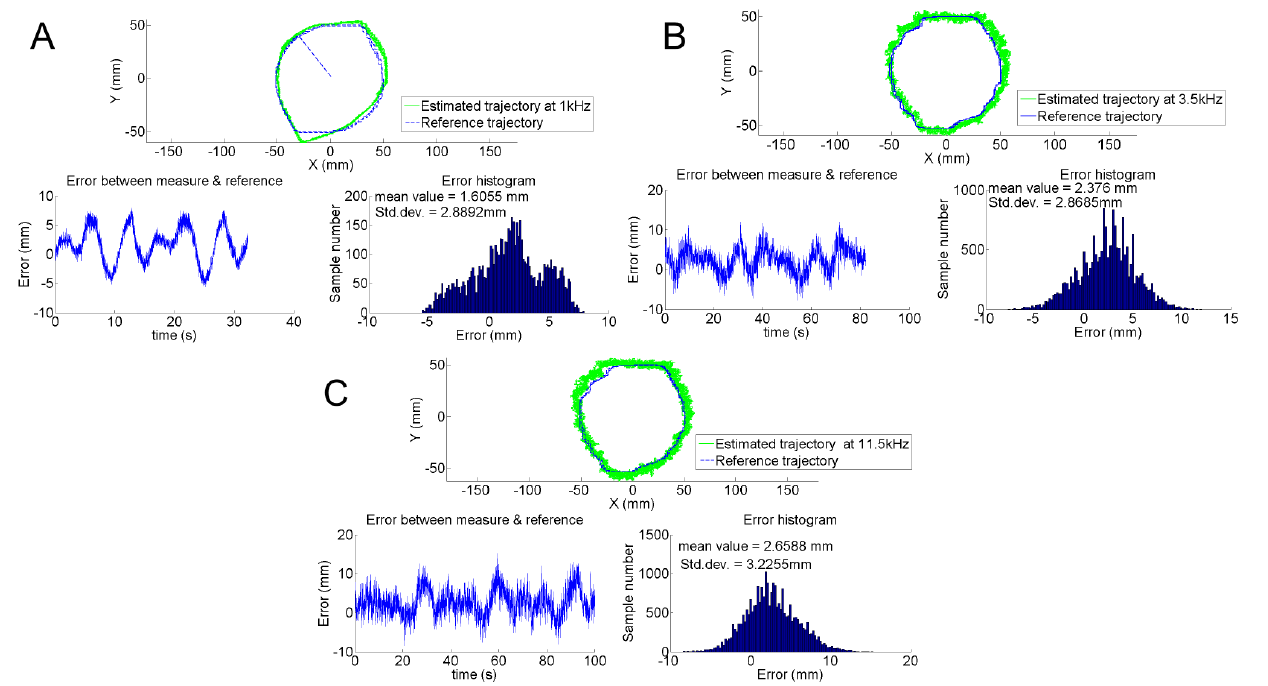
Figure 13. ( A ) Position estimation for a circular trajectory with a radius of 50 mm in the XY plane. Note that the absolute value of the position error is lower than 1 cm and that the standard deviation is about 3 cm; We also note that the noise is more important for the experiments at 3.5 kHz ( B ) and 11.5 kHz ( C